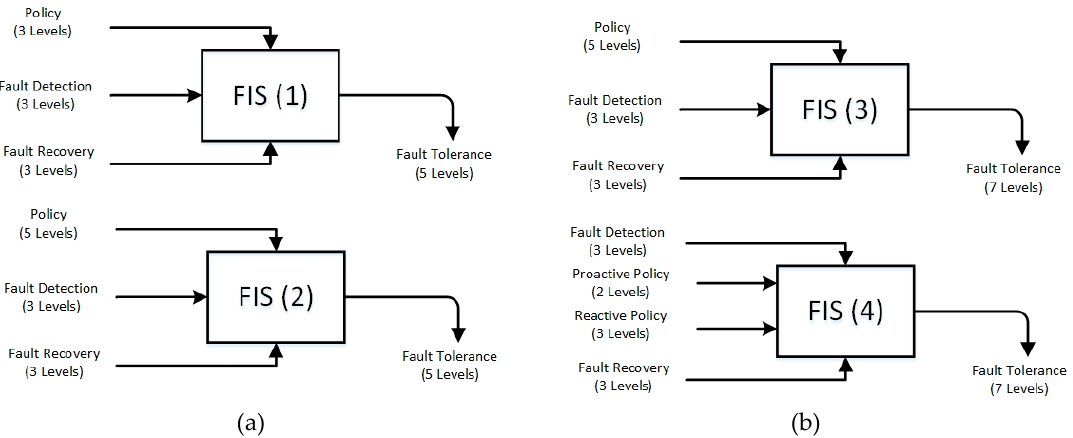
Figure 12. (a) Inputs of the fuzzy engines; (b) outputs of the fuzzy engines. Figure 12. ( a ) Inputs of the fuzzy engines; ( b ) outputs of the fuzzy